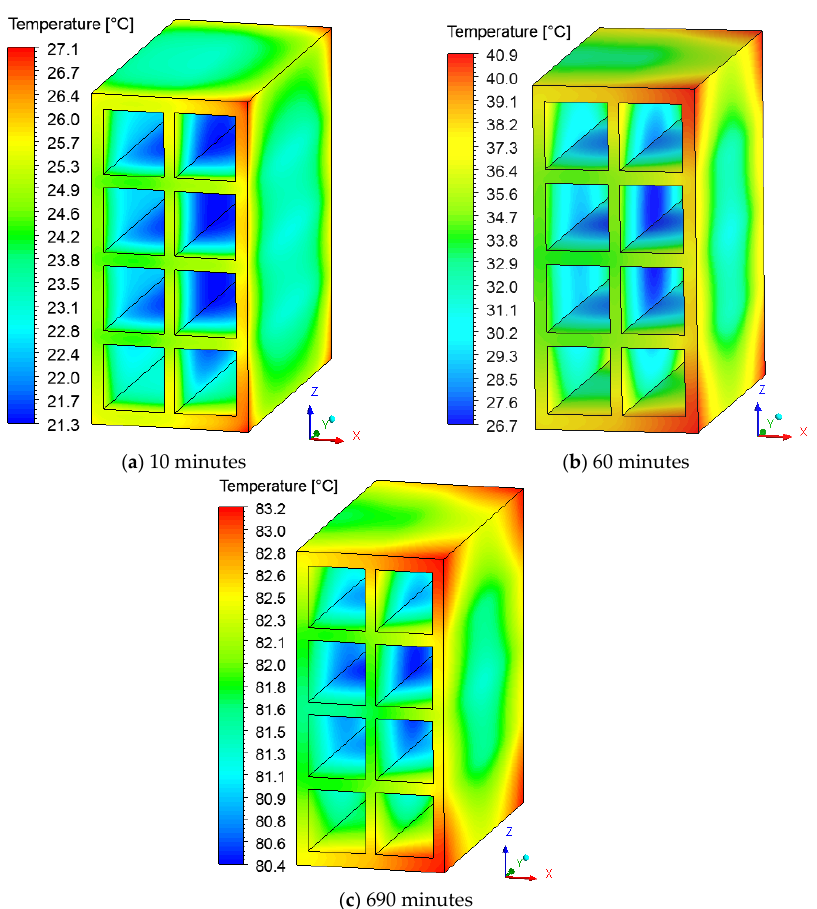
Figure 14. Temperature distribution on the brick surface for drying at 90 °C, with different durations—( a ), ( b ), and ( c) .